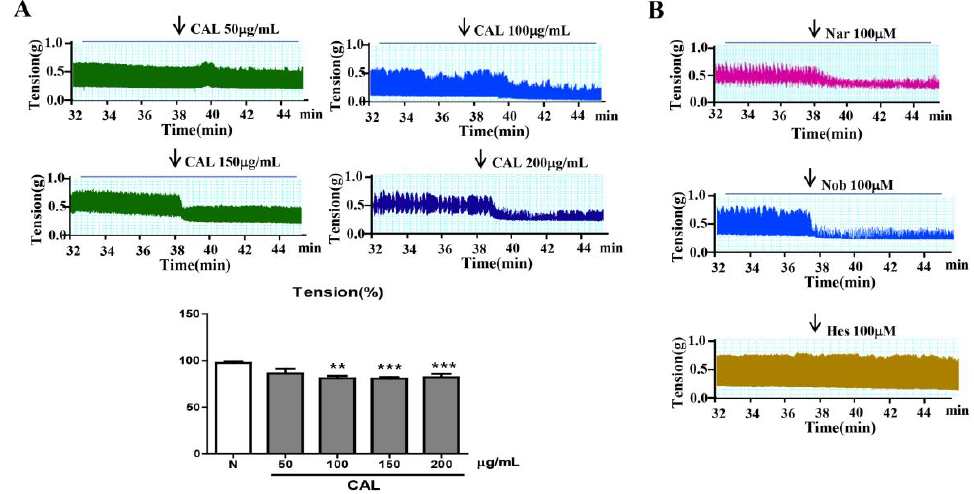
Figure 4. Effect of CAL, naringenin, nobiletin, and hesperetin on isolated jejunum contraction. ( A ) Effect of CAL extraction on isolated jejunum contraction. ( B ) Effects of naringenin, nobiletin, and hesperetin on isolated jejunum contraction. Nar: naringenin; Nob: nobiletin; Hes: hesperetin; n = 6, ** p < 0.01, *** p < 0.001 vs. normal group. Data (mean ± SEM) were analyzed by ANOVA.